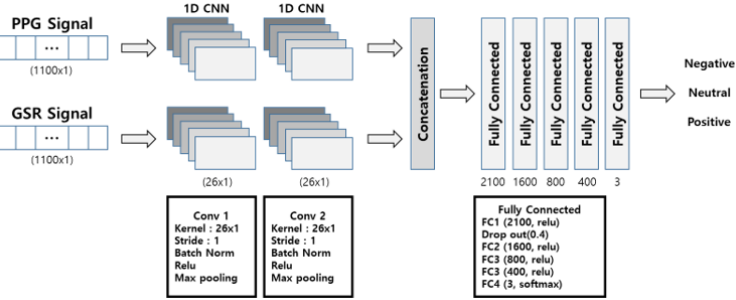
Figure 7. Proposed 1D CNN model for driver’s situation and emotion recognition.